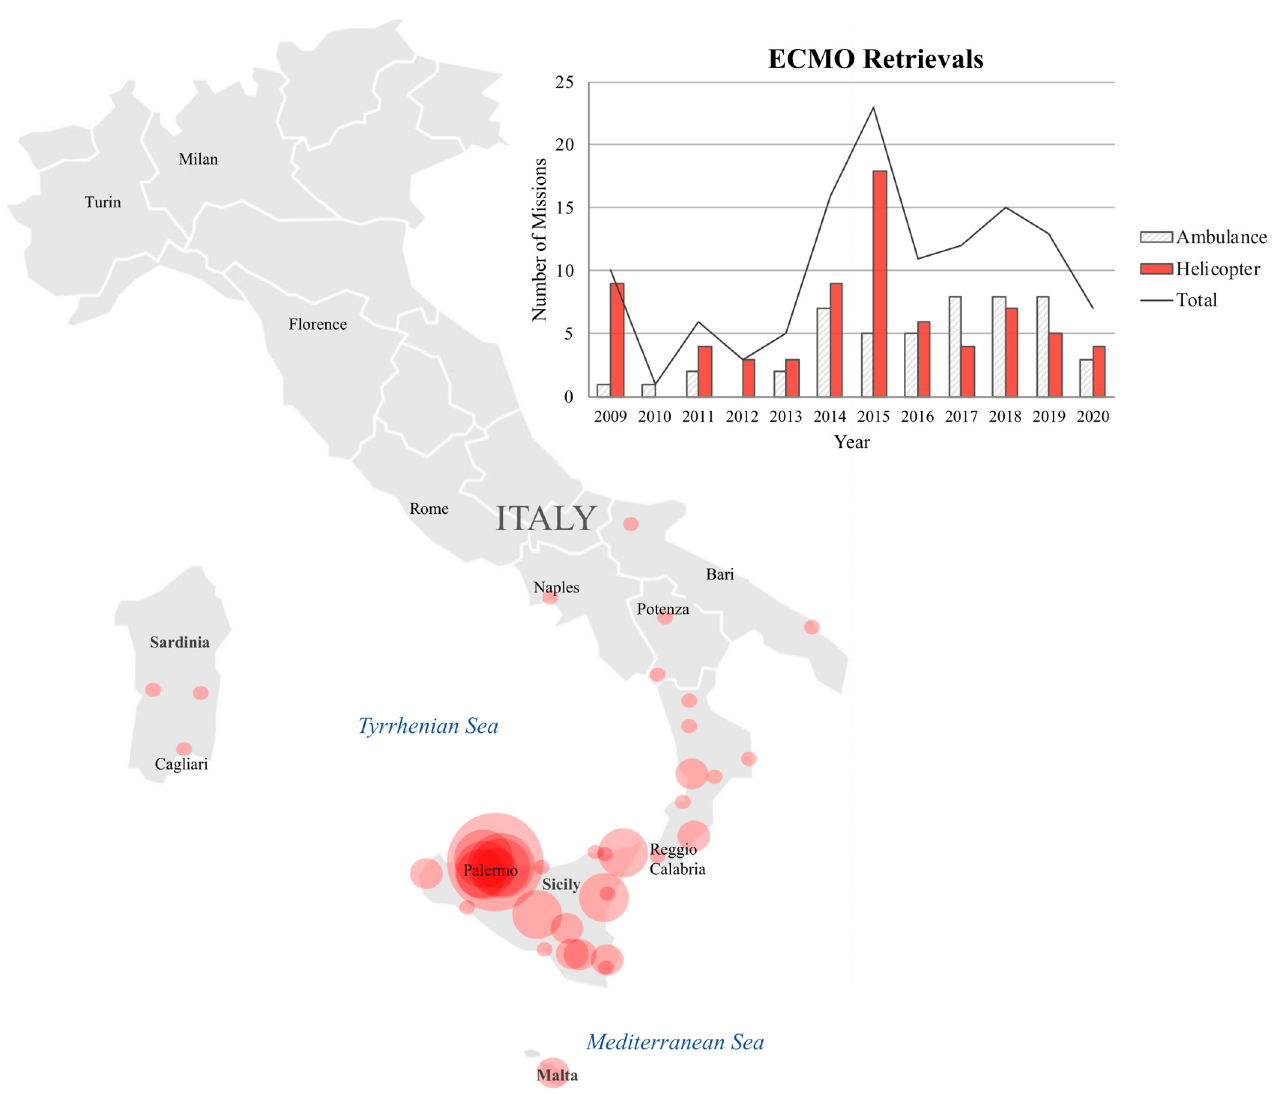
Figure 1. The retrieval map illustrates the geographic distribution of retrievals by referral center, and the bar graph shows the variation in retrieval volume by year. The map was generated using three circles of varying sizes (small, medium, and large), which correspond to the number of retrievals (1–2, 2–3, and 5, respectively). For referral centers with more than five patients retrieved, visual overlay effects were applied. The bar graph depicts retrieval volume by year. White bars represent retrievals by ambulance ( n = 50), red bars represent retrievals by helicopter ( n = 72), and the gray line is the yearly retrieval variation for both cohorts combined ( n =